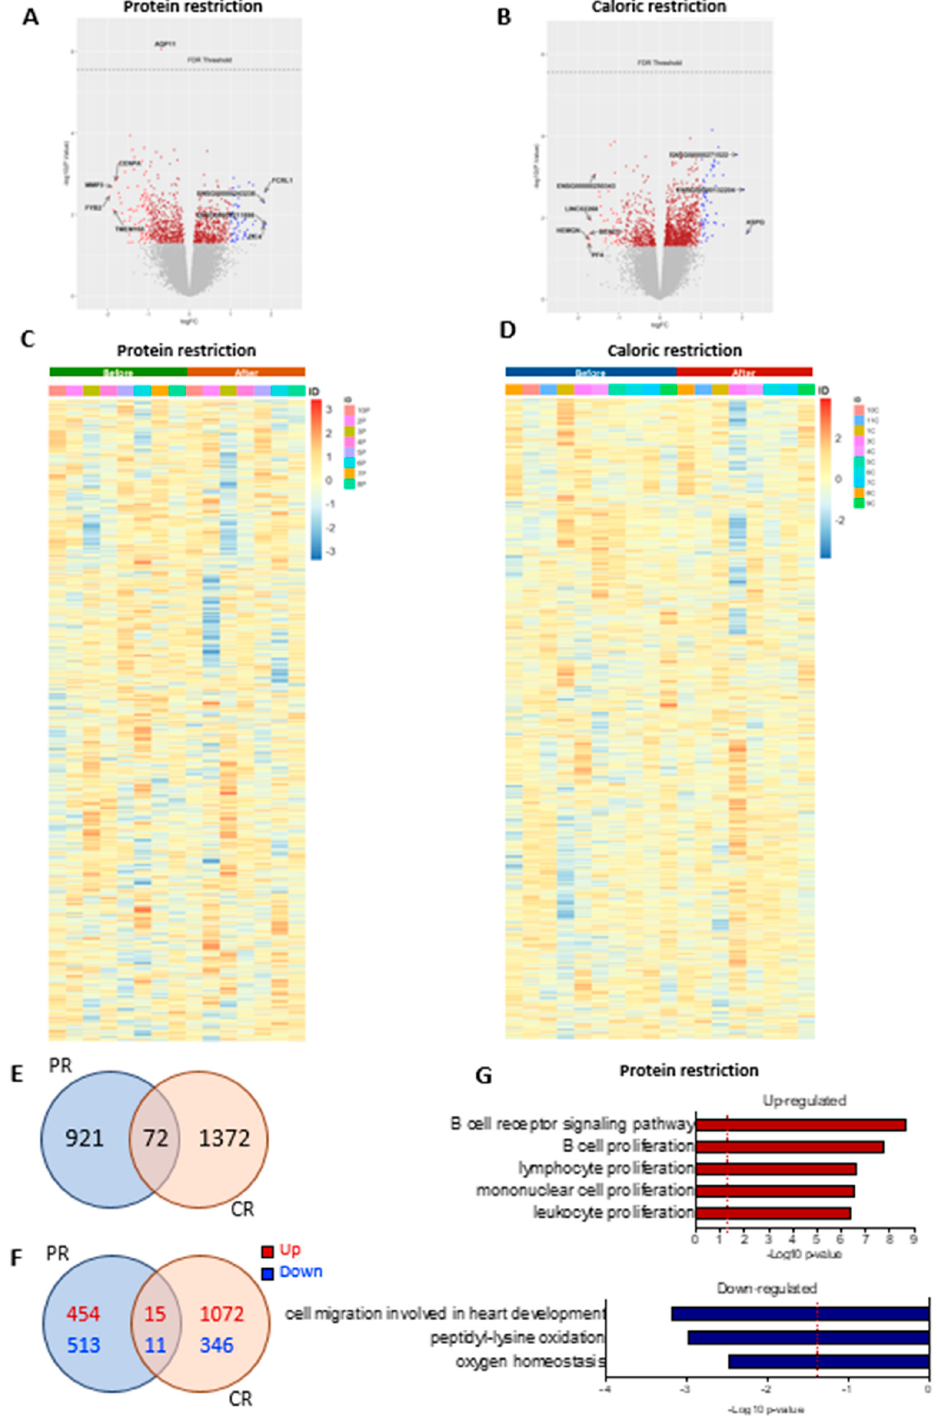
Figure 6. Differential gene expression after protein restriction (PR) or caloric restriction (CR). Volcano plots (log2 fold change against − log10 of the p -value) showing distribution of differentially expressed of the ~24,000 transcripts ( A ) before and after PR, and ( B ) before and after CR. Heatmap representation of gene expression (upregulation in red and downregulation in blue) of the individual samples comparing before and after PR ( n = 8) ( C ), and before and after CR ( n = 10) ( D ). Venn diagrams of adipose tissue and overlapping genes regulated by PR or CR: ( E ) total genes, ( F ) up- and downregulated genes; p -value < 0.05. GO terms enriched in genes upregulated and downregulated in adipose tissue after PR ( G ).